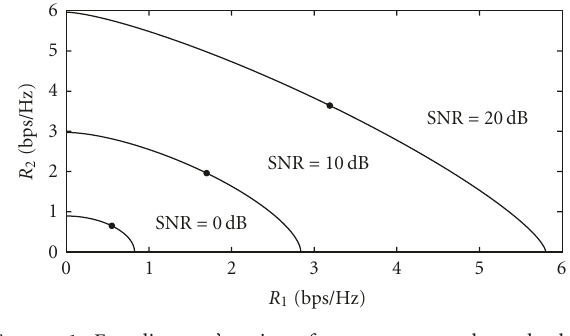
Figure 1: Ergodic rates’ regions for a two-users channel when = 3dB. g / g 1 2